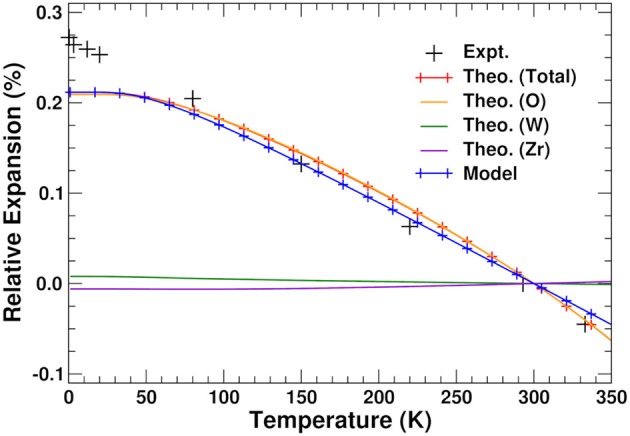
Total, O, W, and Zr components, and results from our two-pole model (see text) of relative thermal expansion in ZrW2O8 as a function of temperature. The experimental results are taken from Evans et al. (1996).